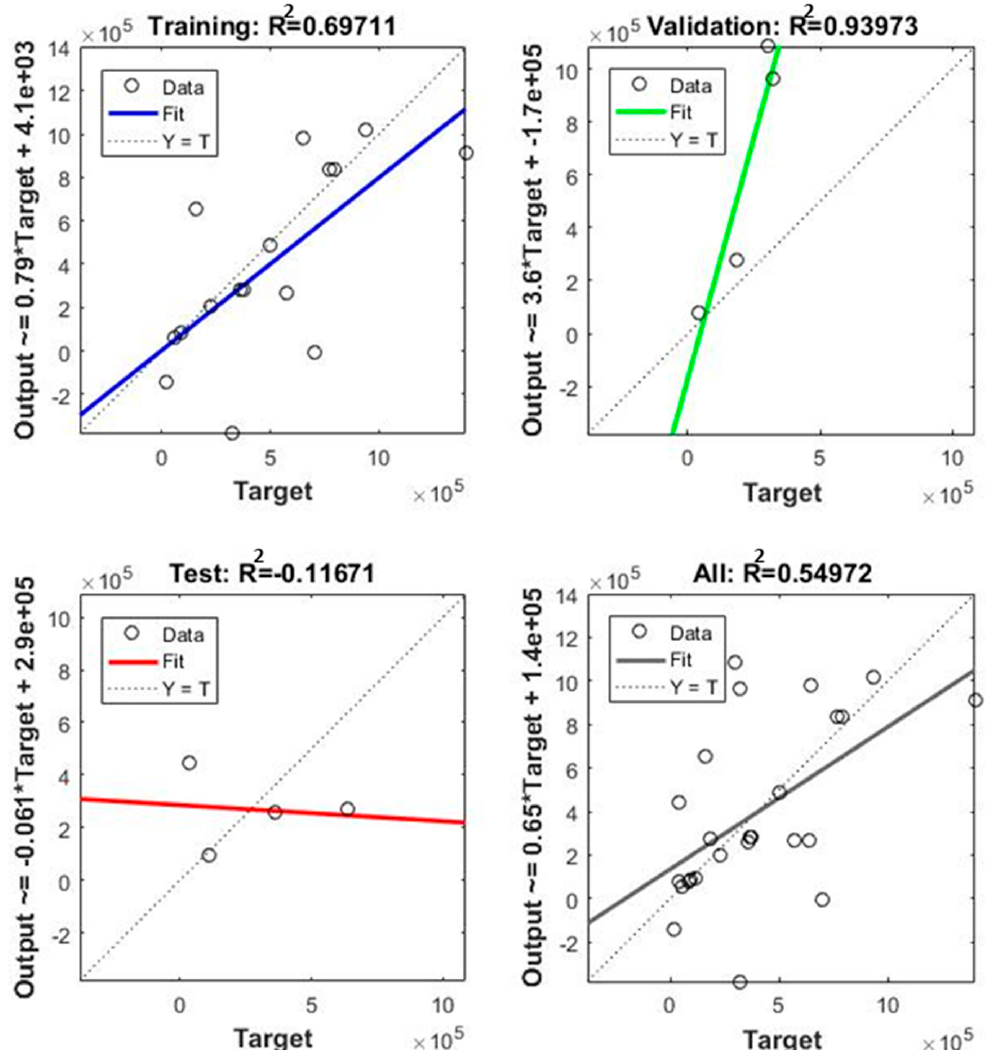
Figure 7. Accuracy of fitted curve of trained model.